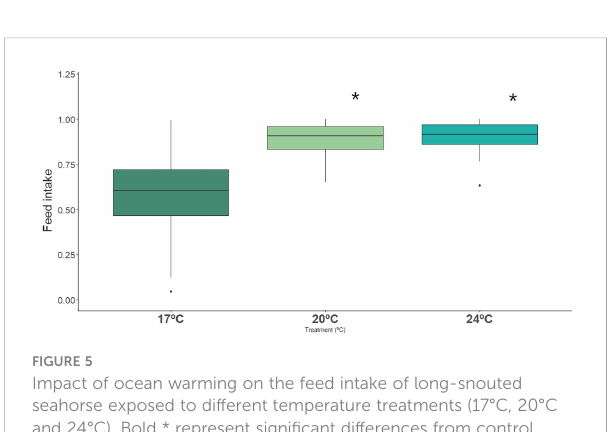
FIGURE 5 Impact of ocean warming on the feed intake of long-snouted seahorse exposed to different temperature treatments (17°C, 20°C and 24°C). Bold * represent signi fi cant differences from control treatment.